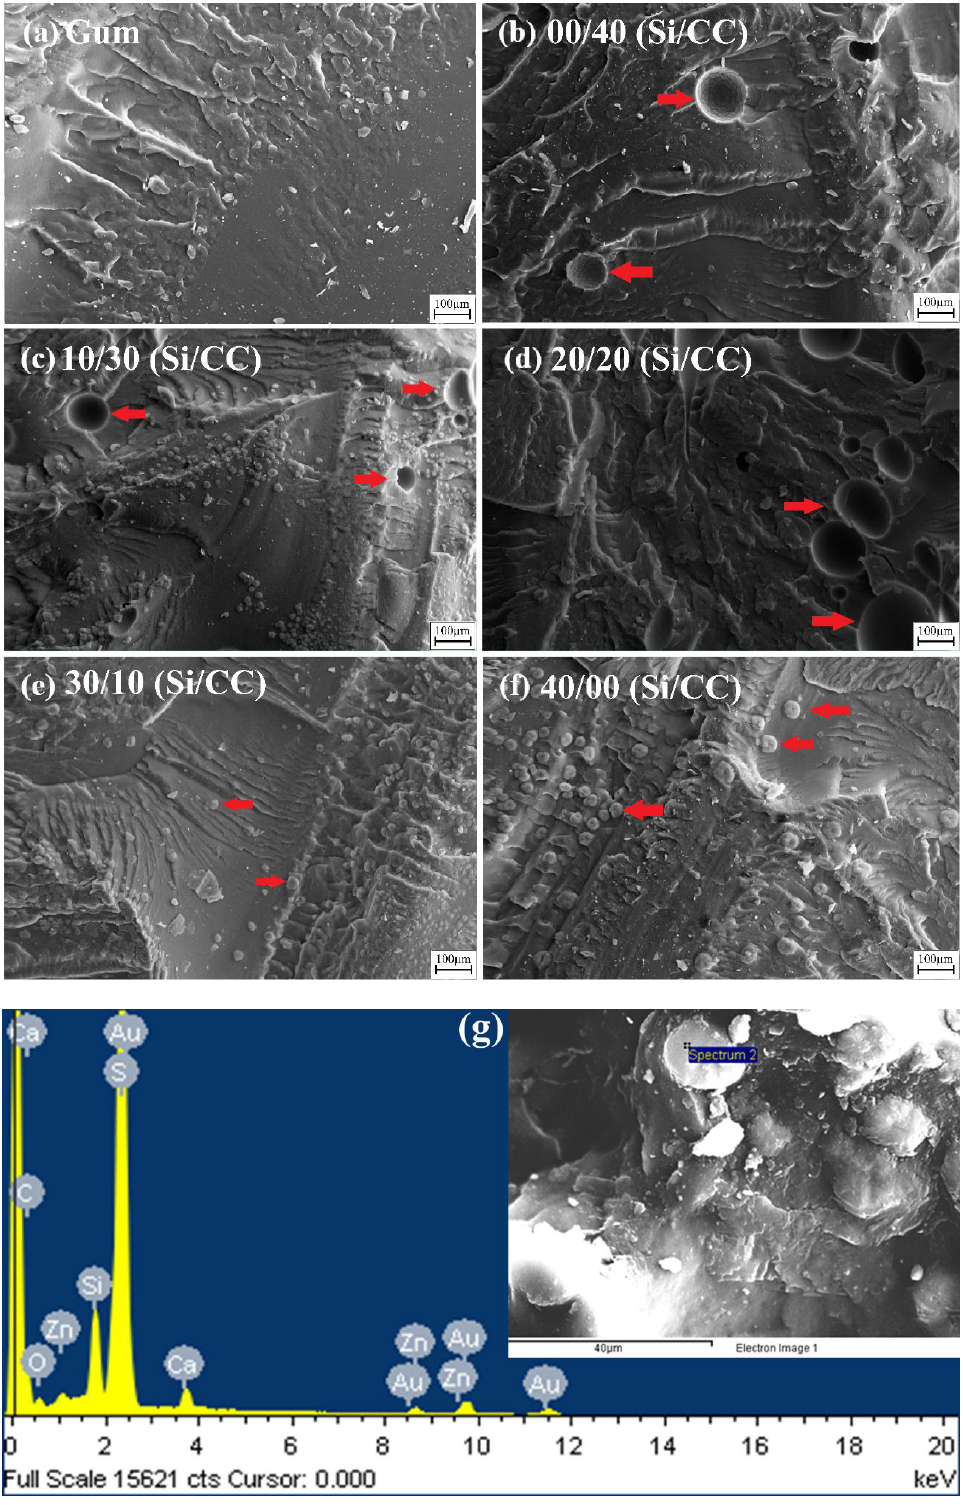
Figure 11. SEM images enlarged 200 times (cryogenically broken samples fixed with double-faced carbon conductive tape on one side and metalized with a thin layer of gold on the other side) of ( a ) gum and the NR-silica hybrid composites (SiO 2 + Si69 ® ) with calcium carbonate (CaCO 3 ) treated with 2% Chartwell: ( b ) 00/40, ( c ) 10/30, ( d ) 20/20, ( e ) 30/10, and ( f ) 40/00. All the fractions are in phr. ( g ) EDS of the 30/10 (Si/CC in phr)